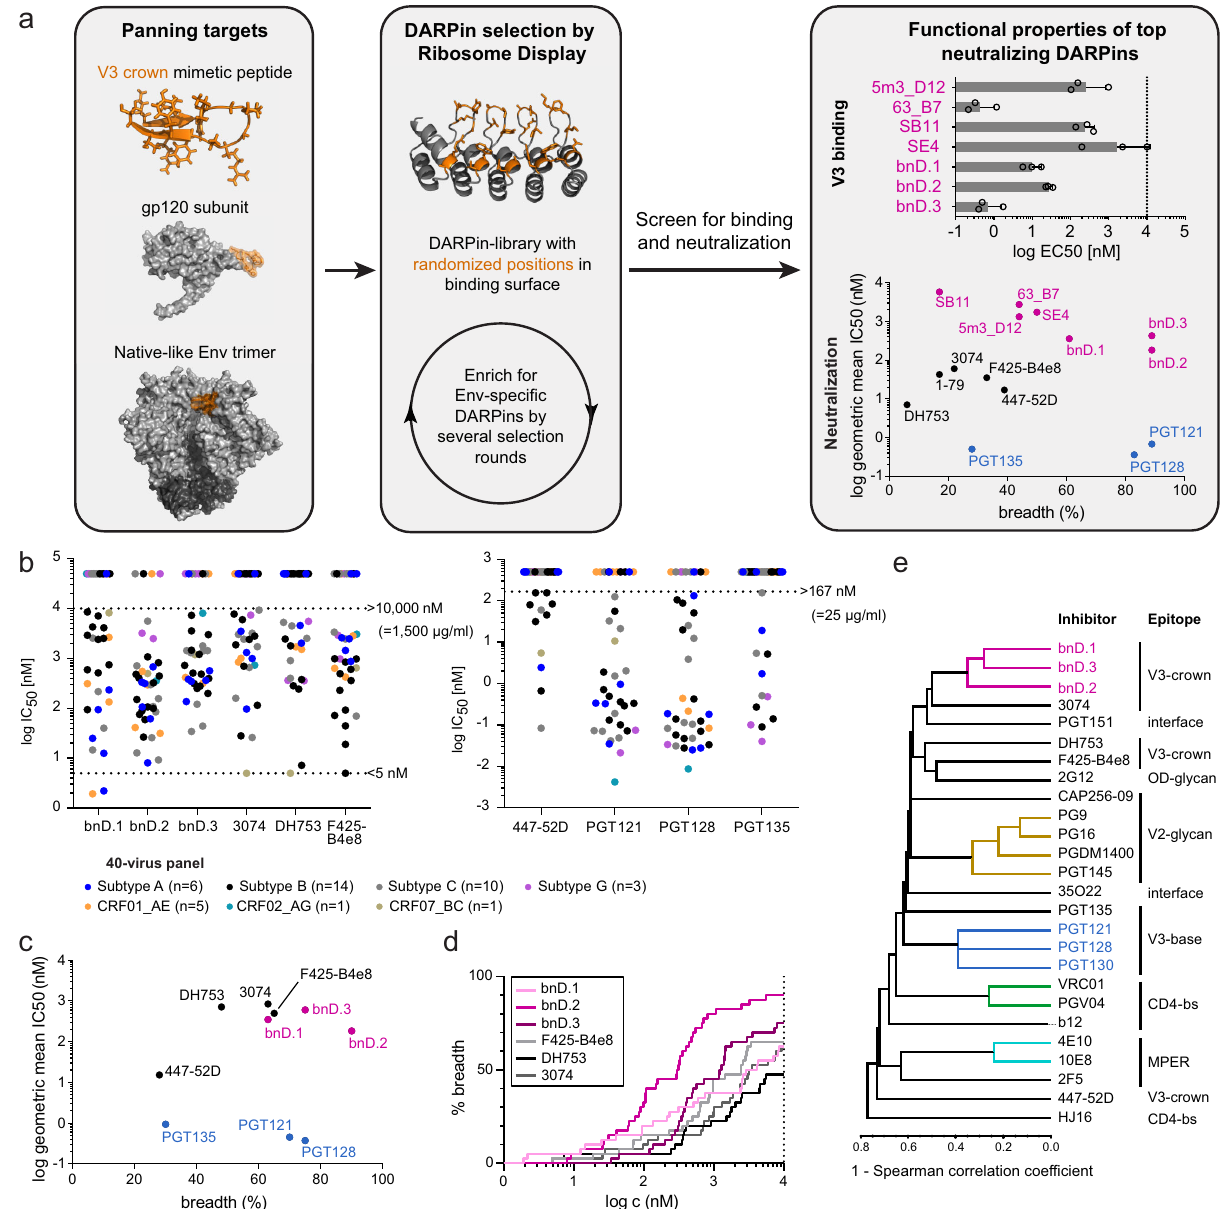
Fig. 1 Selection of V3-crown reactive broadly neutralizing DARPins (bnDs). a Scheme of the selection work fl ow to identify V3-crown-reactive neutralizing DARPins. For details on panning, ribosome display selections, and the screening procedure, see Supplementary Fig. 1 and 2 as well as the Materials and Methods section. The right panel depicts V3-crown binding and neutralizing activity of the top six neutralizing DARPins and the reference DARPin 5m3_D12 selected for follow-up experiments (magenta). V3-crown nAbs (black) and V3-base bnAbs (blue) are shown for comparison. V3-crown binding is depicted as 50% effective concentration (EC 50 ) (nM) derived by ELISA. Bars indicate the geometric mean EC 50 values from three independent replicates (circles). Error bars depict the geometric standard deviation (SD). The neutralization breadth-potency plot is based on results from a multi-clade 18-virus panel (maximum concentrations probed: DARPins (10,000 nM or 20,000nM) and mAbs (167 nM ( = 25 μ g/ml, commonly used for mAbs in this type of assay)) Supplementary Data 1). The geometric mean of 50% inhibitory concentration (IC 50 ) values in a and c were calculated over all sensitive strains. b Extended neutralization analysis of bnDs and nAbs on a 40-virus panel (Supplementary Data 1). IC 50 values (geometric mean of 1-5 independent replicates) are shown. Minimum (5 nM: only for mAbs 3074, DH753 and F425-B4e8) and maximum concentrations of DARPins (10,000 nM) and mAbs (10,000 nM or 167 nM ( = 25 μ g/ml) probed are indicated by dashed lines. Viruses not neutralized are shown as dots above the dashed lines. Colors of individual data points indicate virus clade. c Neutralization breadth-potency plot summarizing the data in b . d Neutralization breadth of V3-crown bnDs and nAbs depending on their concentration according to data in b . e Dendrogram based on Spearman correlation (Supplementary Data 2) and single linkage hierarchical clustering depicting the similarity of neutralization fi ngerprints on the 40-virus panel for bnDs and a range of bnAbs and nAbs with different epitope speci fi